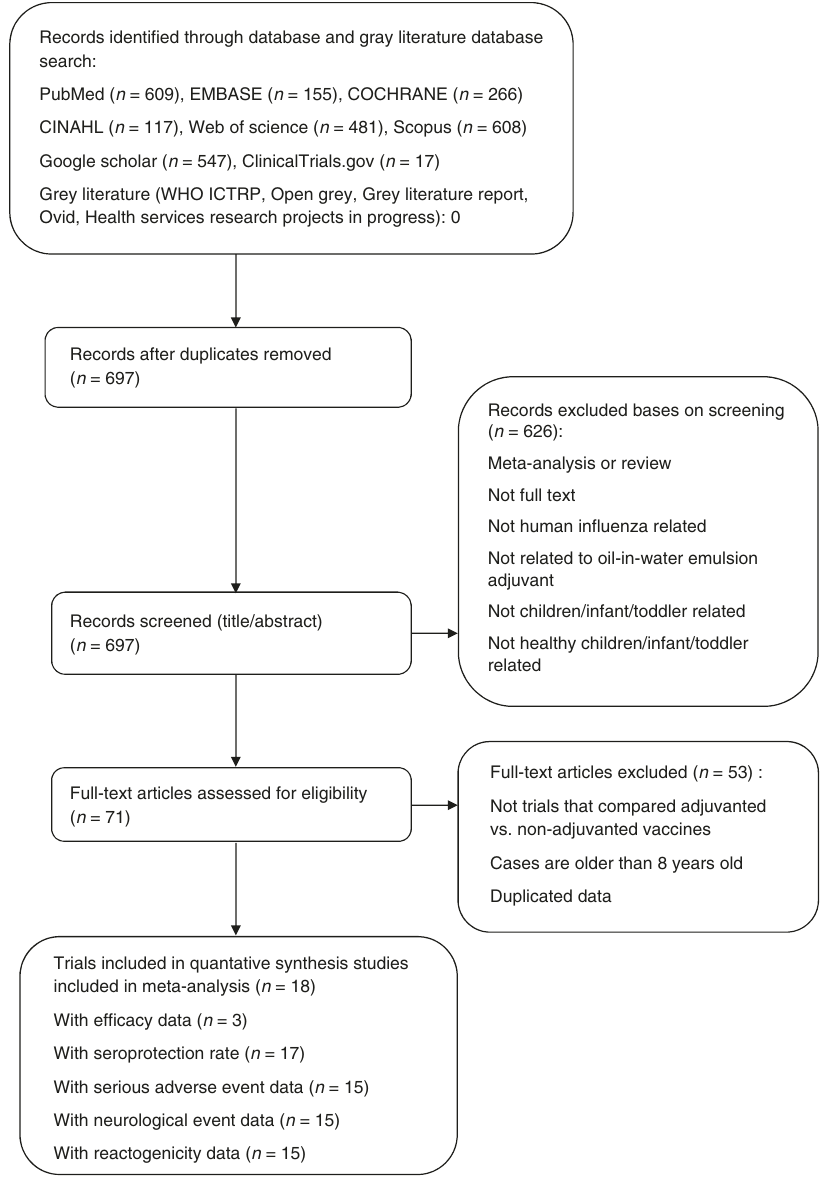
Fig. 1 Flowchart of the literature